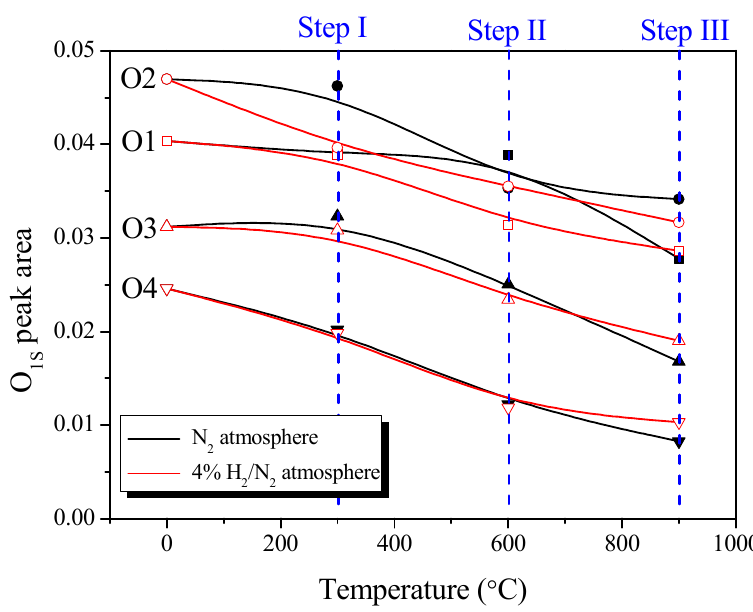
Figure 5. The results of deconvoluted high ‐ resolution O 1S spectrum of AC ‐ N, AC ‐ H.